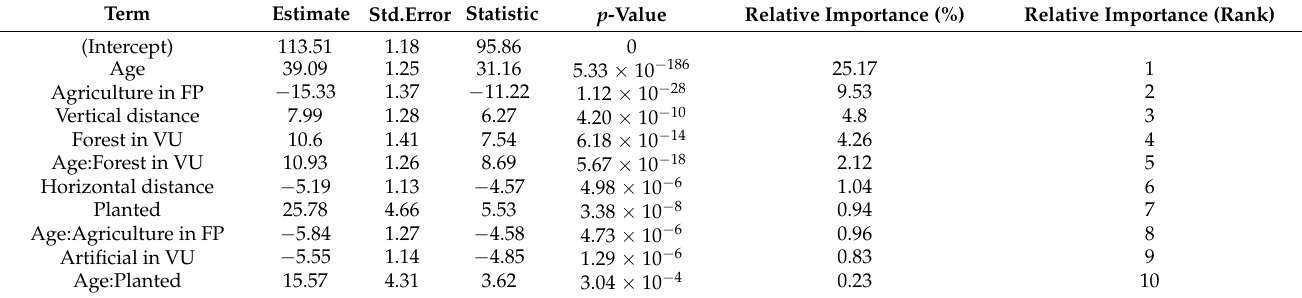
Table 5. Results of MLR with stepwise variable selection to predict VU biomass (following Equation (5)). Explanatory variables were standardized prior to regression. Relative importance corresponds to the proportion of variance explained by each term. The model had an R 2 of